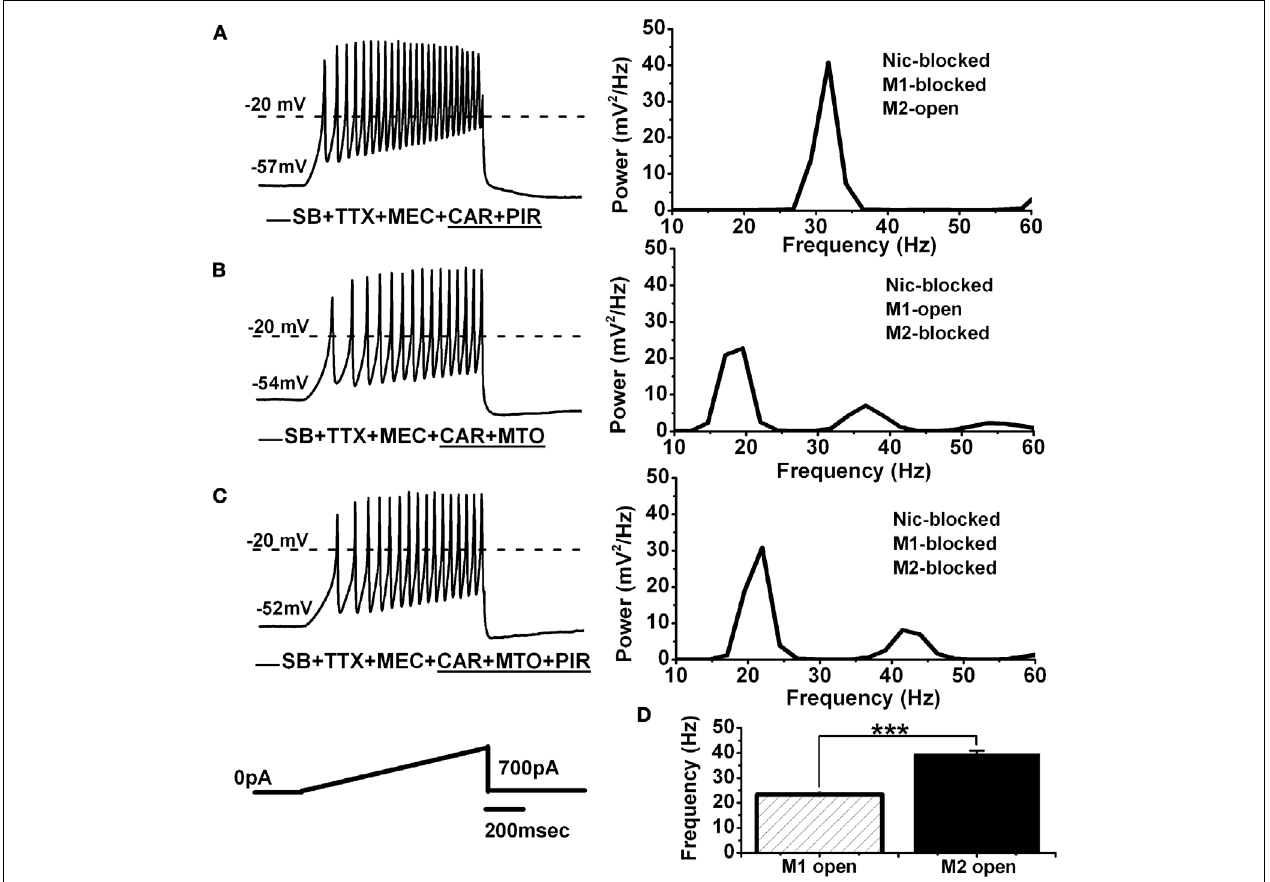
(black record on the left) in the presence of all synaptic blockers including all the cholinergic blockers (MEC + MTO + PIR).The power spectrum on the right side shows oscillatory activity in the beta range, similar to the frequencies observed in the experiment described in (B) . (D) Bar graph showing the mean frequency of membrane potential oscillations for the cells recorded under persistent exposure to CAR where one group had only M1 receptors activated (striped column, n = 7), and the other group had only M2 receptors activated (black column, n = 11). Note that both groups of cells were recorded under the same conditions (SB + TTX + MEC), except for the specific M1 vs. M2 receptor blockers (*** p < 0.001; abbreviations: CAR, carbachol; SB, synaptic blockers;TTX, tetrodotoxin; MEC, mecamylamine; MTO, methoctramine; PIR,